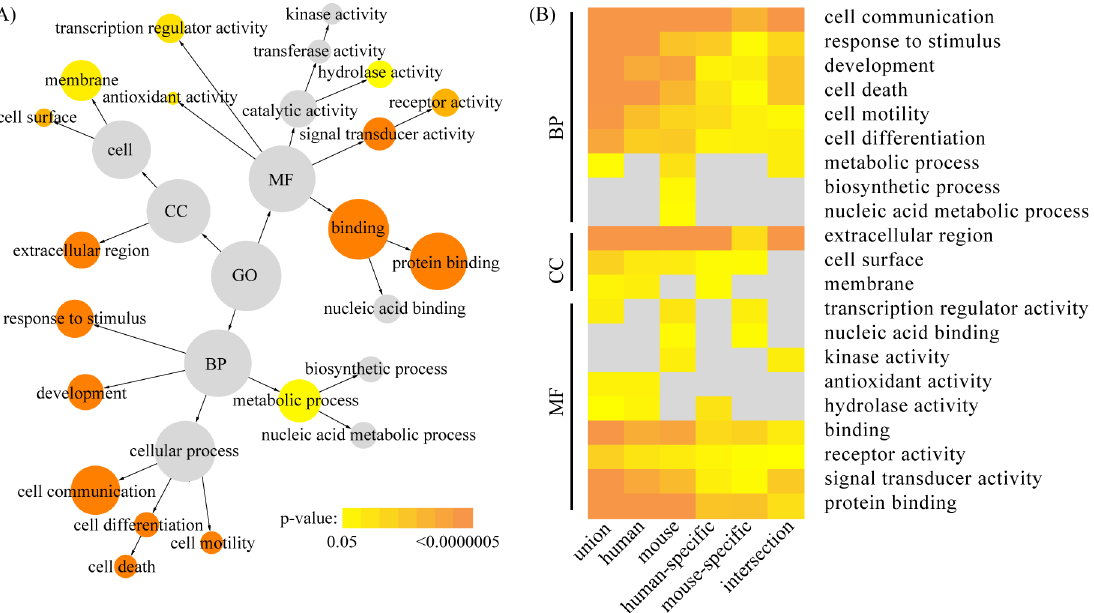
Fig 2. Gene ontology (GO) enrichment analysis of decidualization-related genes. (A) The union of human and mouse gene sets were analyzed using BiNGO software. Significantly enriched GOslim categories were highlighted with different colors representing different levels of significance. The size of each circle is correlated to the number of genes. (B) Comparative GO enrichment analysis for species-specific gene sets arranged in the biological process category (BP), the cellular component category (CC) and the molecular function category (MF), respectively. The analysis was applied to human and mouse gene sets, as well as 4 additional gene sets generated by set operations (union, intersection and difference) between them. The columns represent different gene sets, while the rows represent statistically significant GO terms.